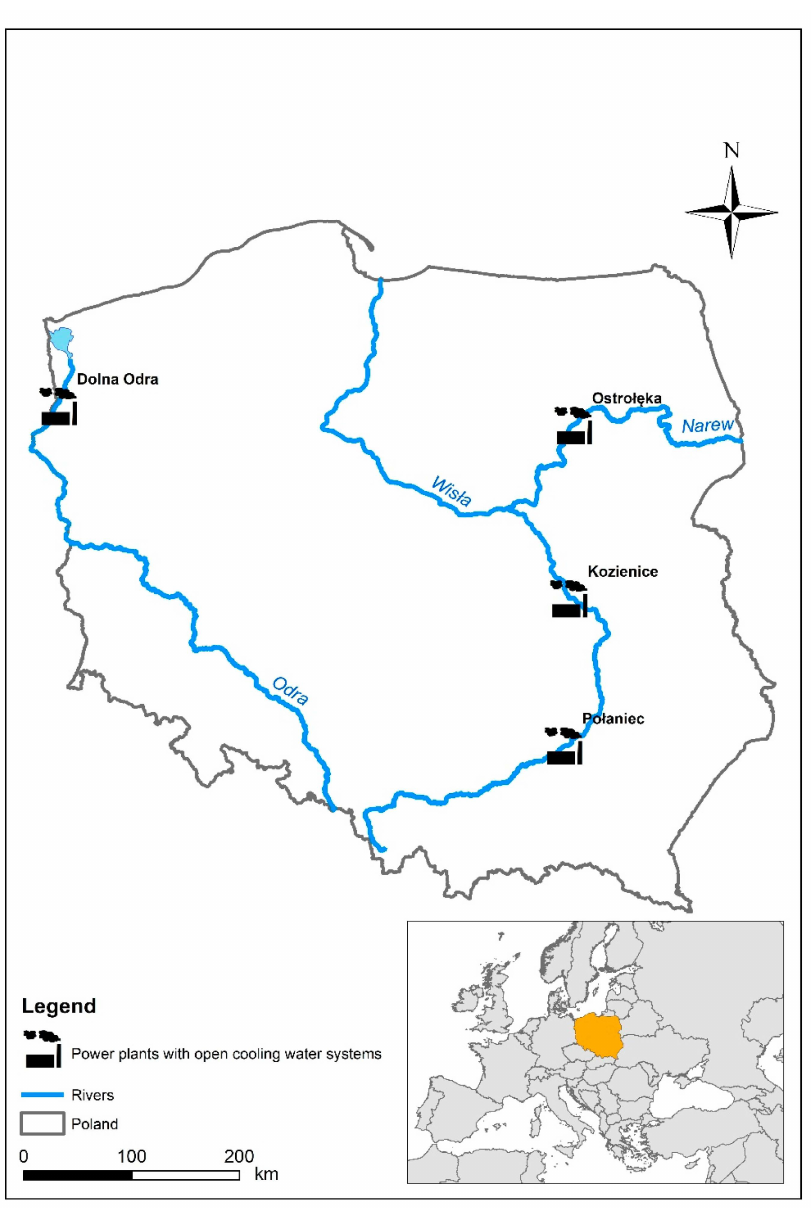
Figure 1. Power plants with an open cooling